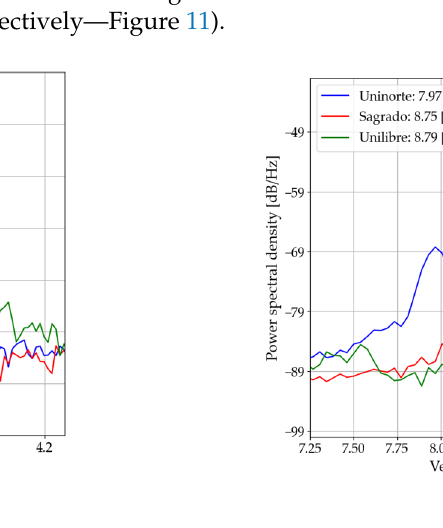
Figure 13. Power spectral density of experimental frequencies of the bridges: ( a ) lateral and ( b ) vertical.